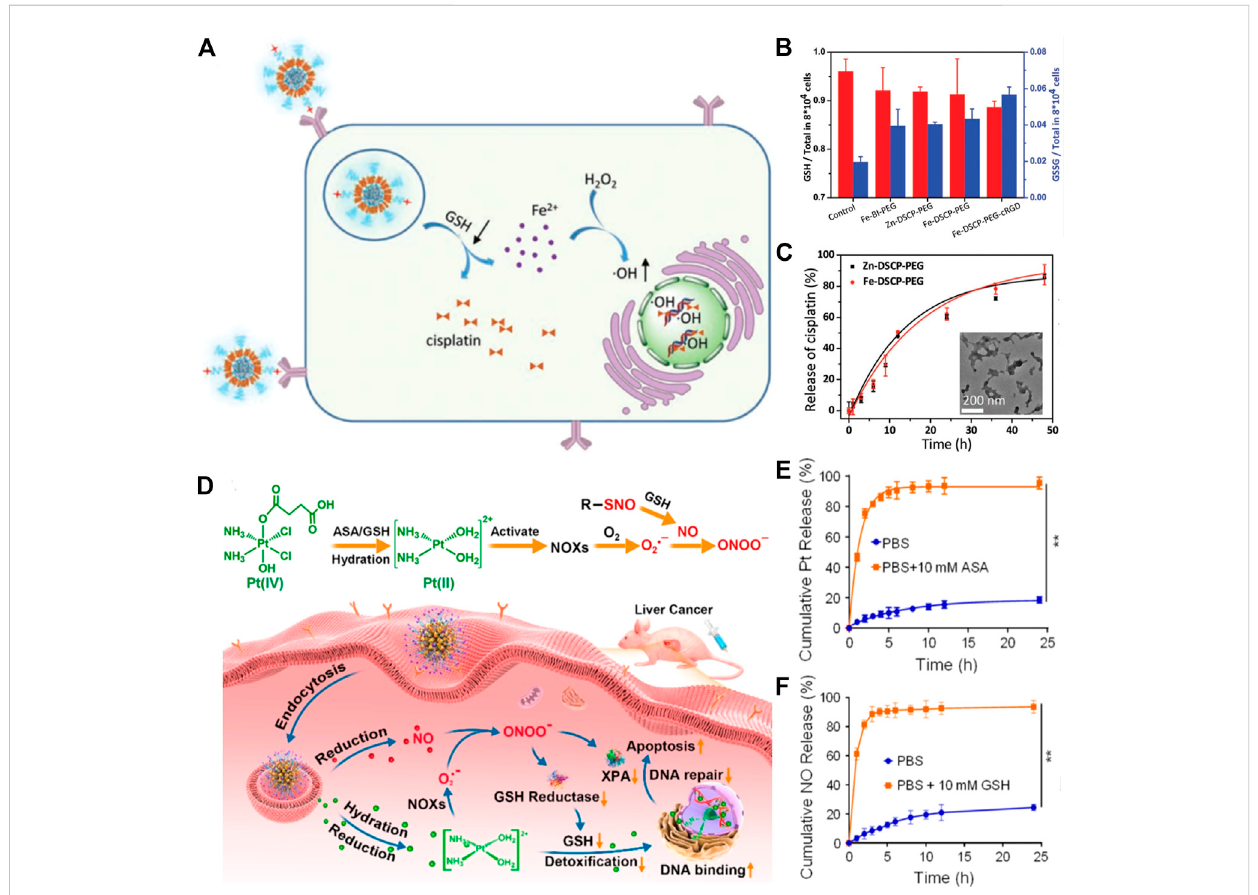
FIGURE 3 (A) Illustration showing GSH consumption induced Fe 3+ and active cisplatin release, and ROS-mediated DNA damage. (B) The GSH and GSSH contents in C6 cells after performing various treatments. (C) The cisplatin release behavior and transmission electron microscope image of various nanoscale coordination polymers after treatment with GSH. Reproduced with permission. Copyright 2020 American Chemical Society. (D) Schematic illustrationofONOO − generationbySPNAforenhancedPt-basedchemotherapy. (E) Ptand (F) NOreleasebehaviorsofSPNAinPBSwithorwithout ASA/GSH (ASA is a reductive substance similar to GSH). Reproduced with permission. Copyright 2021 American Chemical